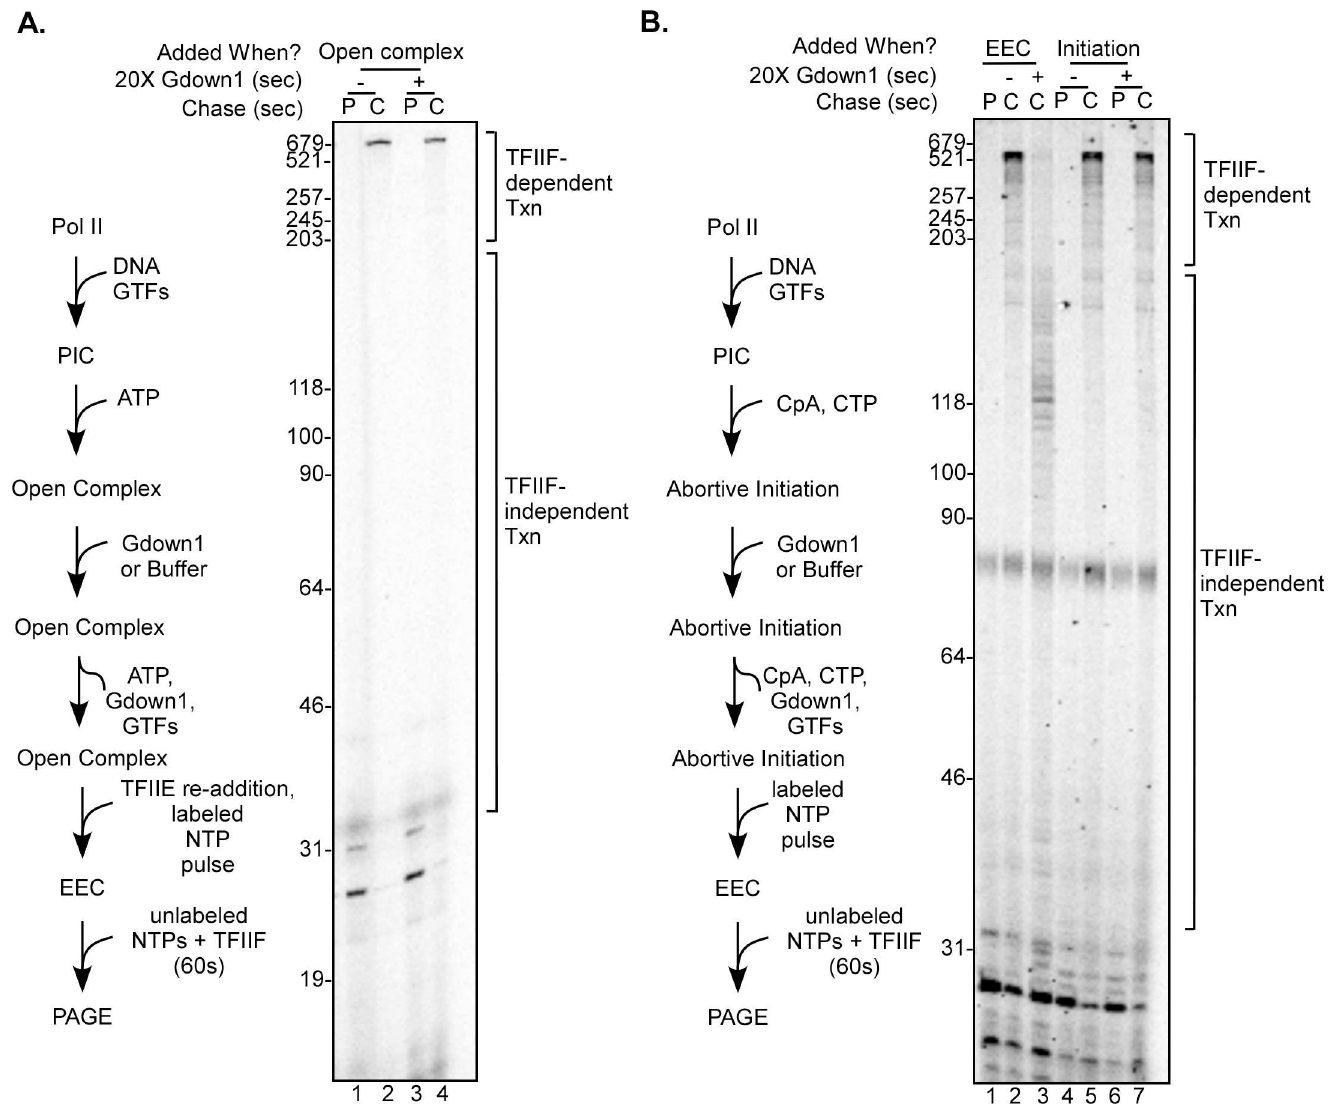
Materials and Methods. After the supernateswere removed and replacedwith buffer M5, reactions were supplemented with TFIIE and EECs were generated by pulse labelingwith ATP, UTP and [ α - 32 P]CTP as described in Materials and Methods. Reactions were either stopped at this point (P lanes) or supplemented with TFIIF and chased (C lanes) for 60 sec with 200 μ M NTPs as describedin Materials and Methods. Lengths of markers are shown on the left edge of the gel and TFIIF-dependent and TFIIF-independenttranscript lengths are noted on the right. A schematic of the assay is shown to the left of the gel. The gel shown is representative of three replicates that were performed. (B) For lanes 4–7, complexes undergoing abortive initiationwere generatedon bead bound AdML 31g(M) templates with CpA and CTP as describedin Materials and Methods. Reactions in lanes 6 and 7 contained240 fmol of Gdown1. After 5 minutes the supernatantwas removed and replaced with MEMDM40. EECs were then generated with ATP, UTP and [ α - 32 P]CTP as describedin Materials and Methods. Reactions were either stopped at this point (P lanes) or supplemented with TFIIF and chased (C lanes) for 60 sec with 200 μ M NTPs. Control reactions shown in lanes 1–3 were performed as describedin Fig 3 (EEC lanes). The lane 1 reaction was stopped after the pulse (P) step; for the two chase (C) reactions, Gdown1 was incubatedfor 5 min with the 30-mer complexes only for lane 3. Lengths of markers are shown on the left edge of the gel, and lengths of TFIIF-dependent and TFIIF-independent transcripts are noted on the right. A schematic of the assay in lanes 4–7 is shown to the left of the gel. The gel shown is representative of three replicates that were